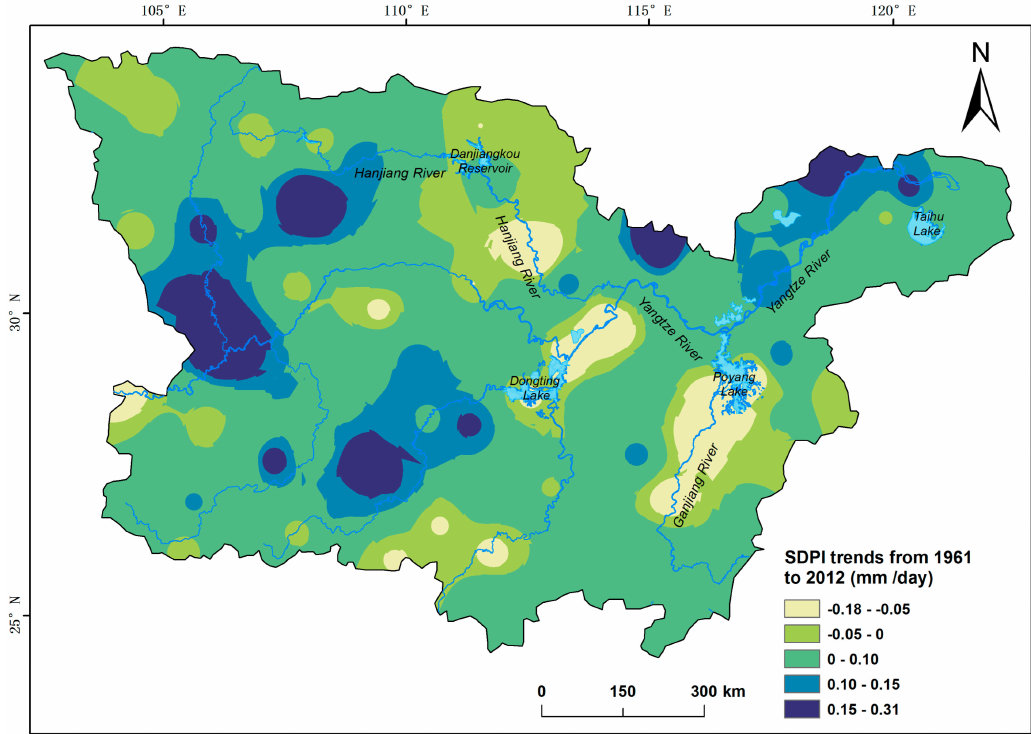
Figure 6. Trends in extreme precipitation intensity over the period of 1961–2012.